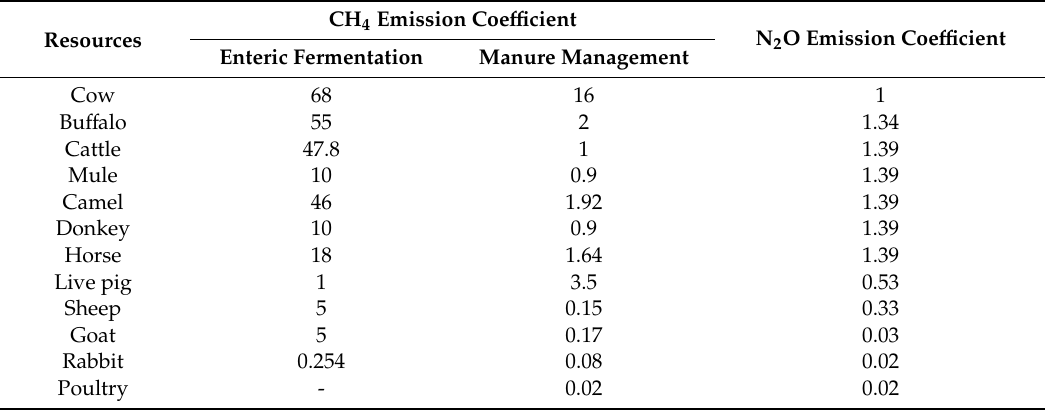
Table 3. The carbon emission coe ffi cients of major livestock (unit: kg / head / year).